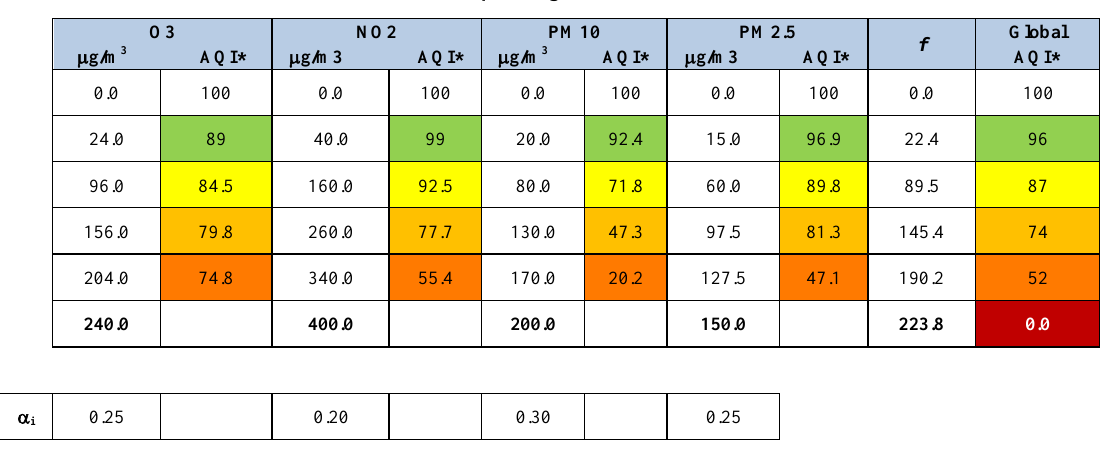
Table 1. Concentration breakpoints for each considered air pollutant; in bold, maximum values assigned. Column f indicates the result according to Equation 4 and exponents are at the last row. In last column, global AQI* values and corresponding color